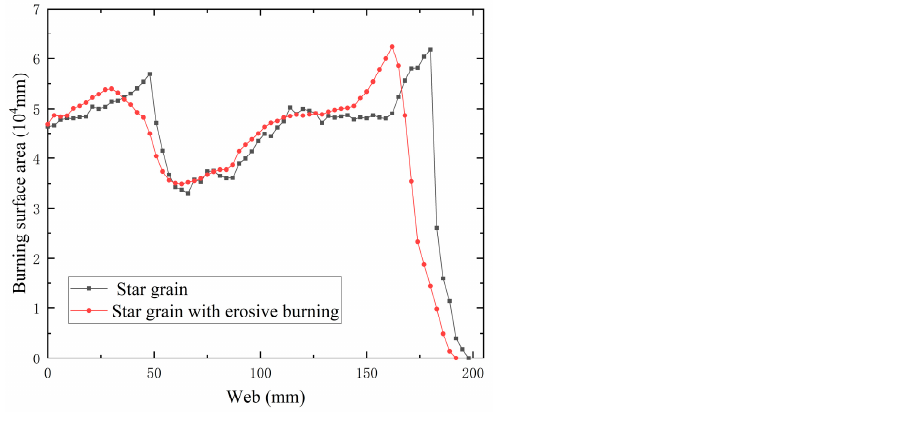
Figure 13. Comparison of burning area of star grains under erosive burning and under geometrical law of burning.